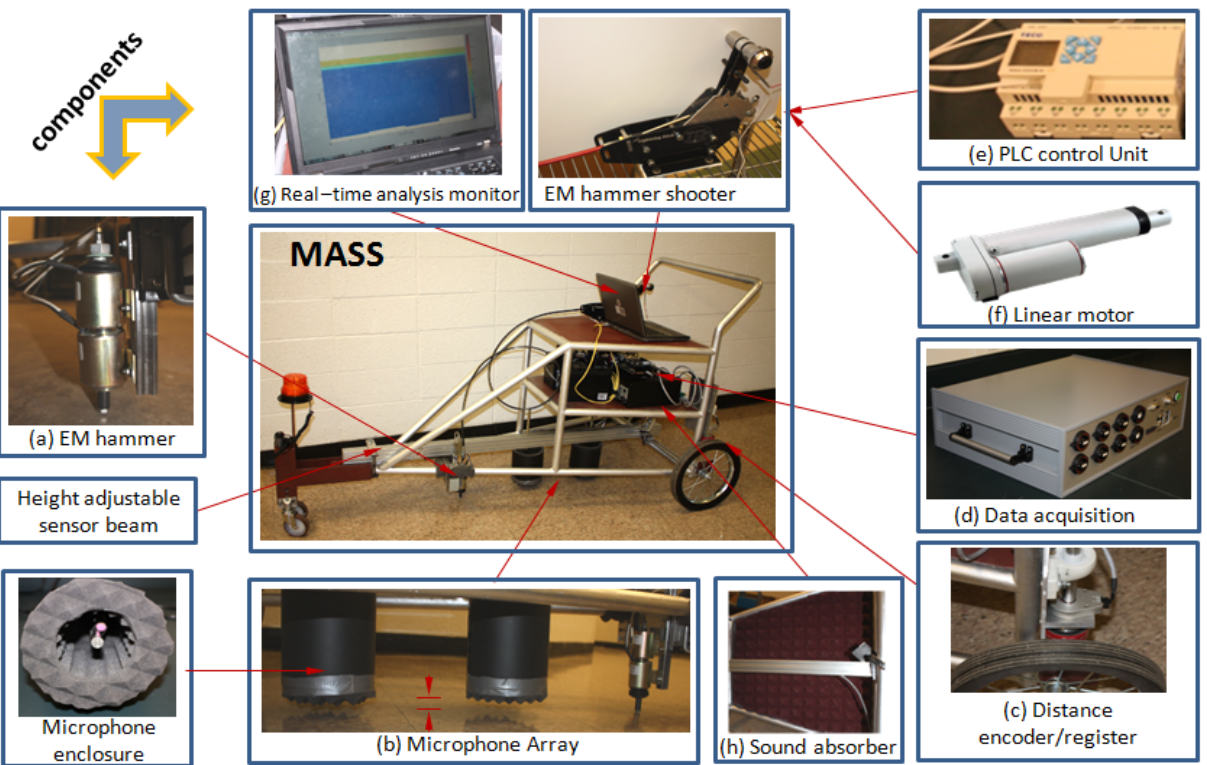
Figure 8. Integration of hardware of